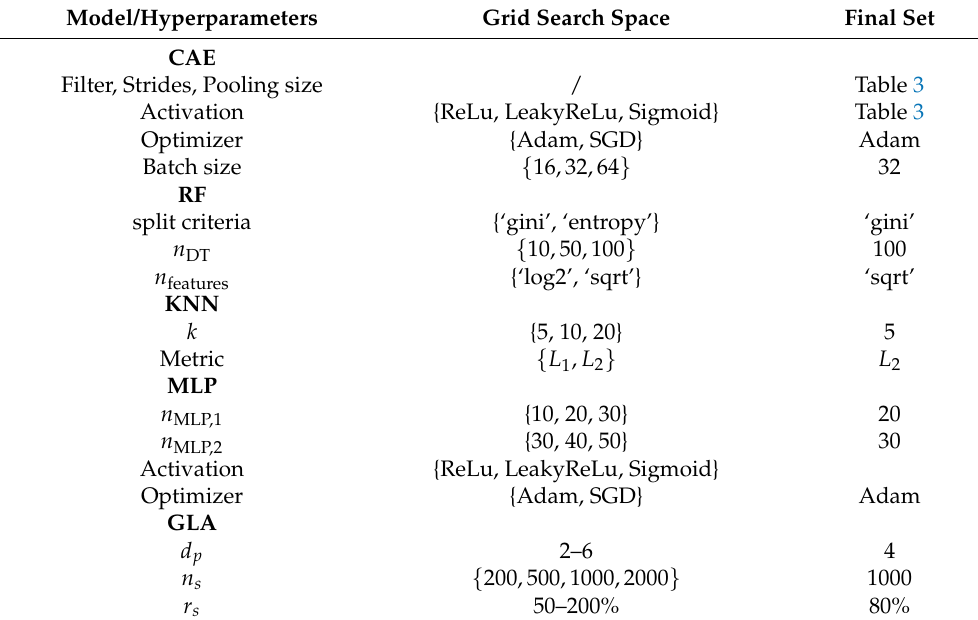
Table 2. Hyperparameter grid search space.